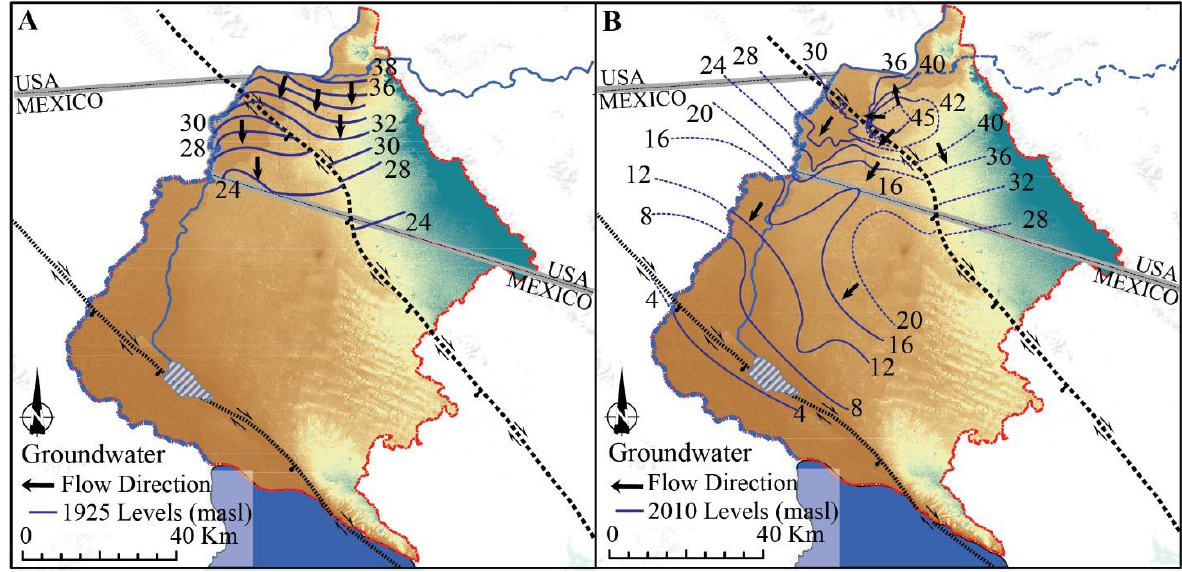
Figure 3. ( A ) Groundwater levels in 1925. ( B ) Groundwater levels in 2010. Contours represent water table elevation in meters above sea level. Based on data from [9,11,25].